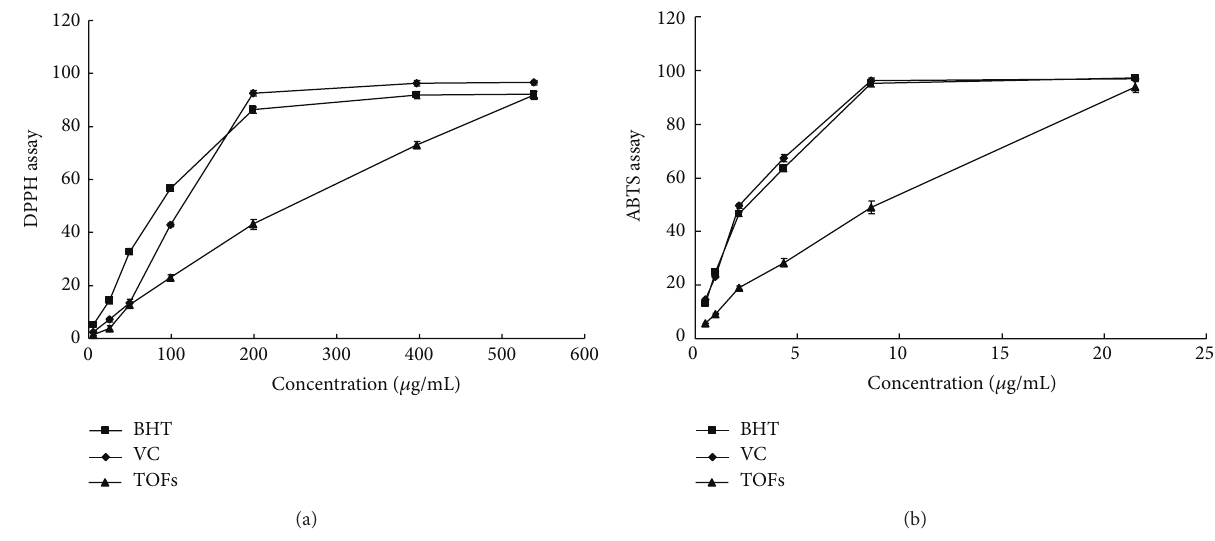
Figure 2: DPPH and ABTS radical scavenging activities of sample and control standard.